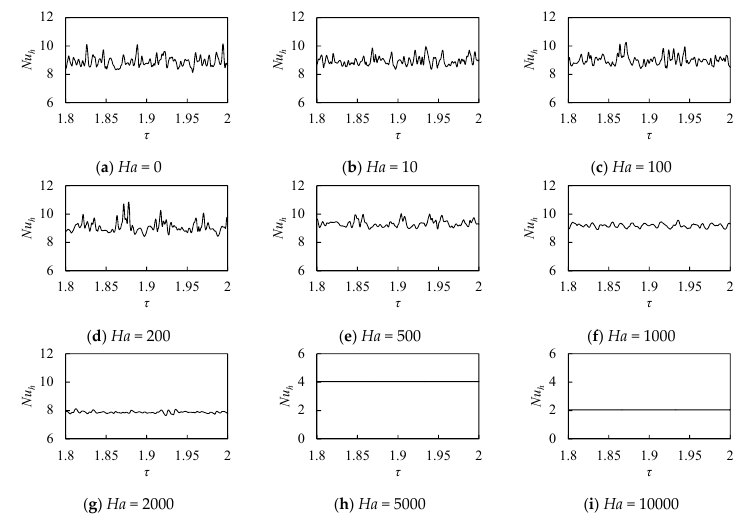
Figure 11. Time development of Nu h at κ = 0.5 and Ra = 10 7 . Energies 2020 , 1 3 , x FOR PEER REVIEW